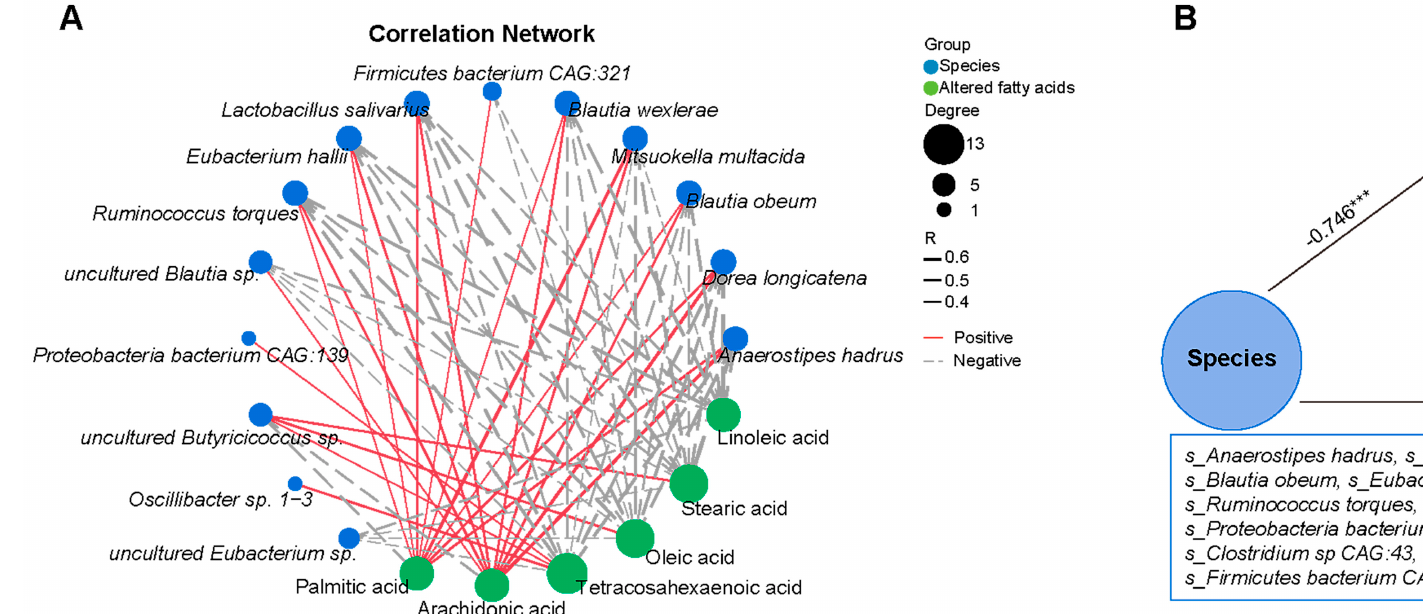
Figure 8. Association between GM dysbiosis and altered saturated and unsaturated fatty acids in HTN patients with and without AF. ( A ) Correlation network plot depicting the significant correlations between selected species based on random forest analysis and six different saturated/unsaturated fatty acids in the two groups (all p < 0.05). Spearman’s correlation analysis. ( B ) The partial least squares structural equation modeling (PLS-SEM) model shows the mediation effect of six altered fatty acids in the total effect of gut species on AF occurrence in HTN patients. Path coefficients were indicated, and the variance accounted for (VAF) score was 85.99%. *, p < 0.05, ***, p <